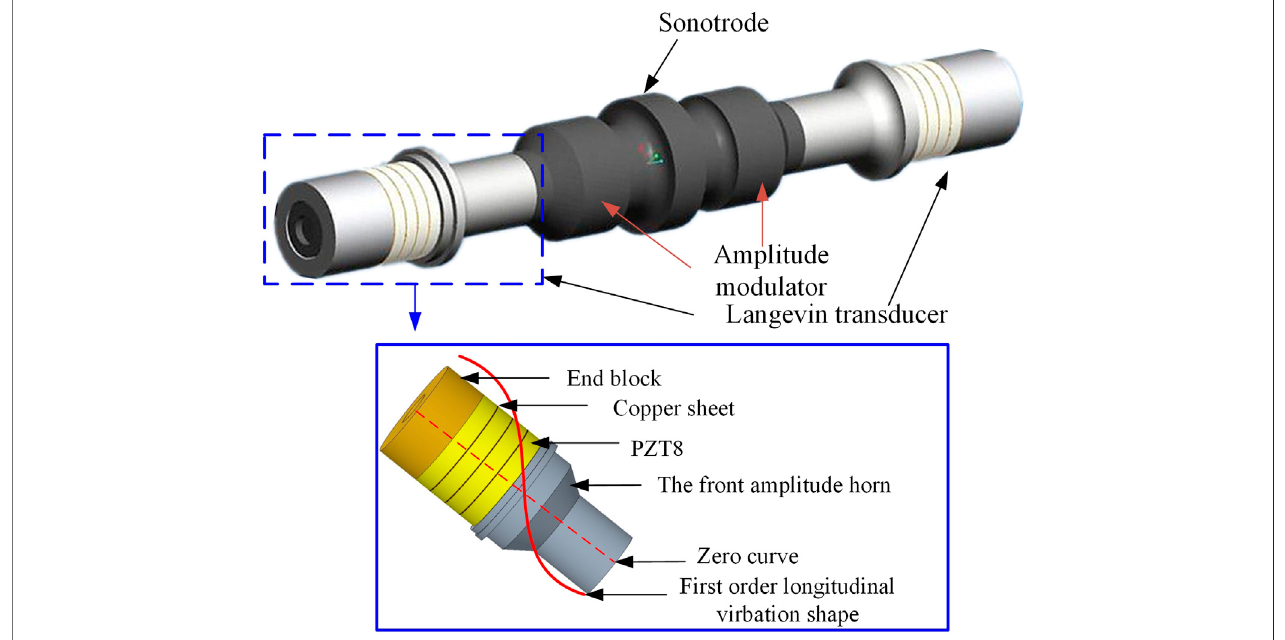
FIGURE 1 | Construction of the sonotrode